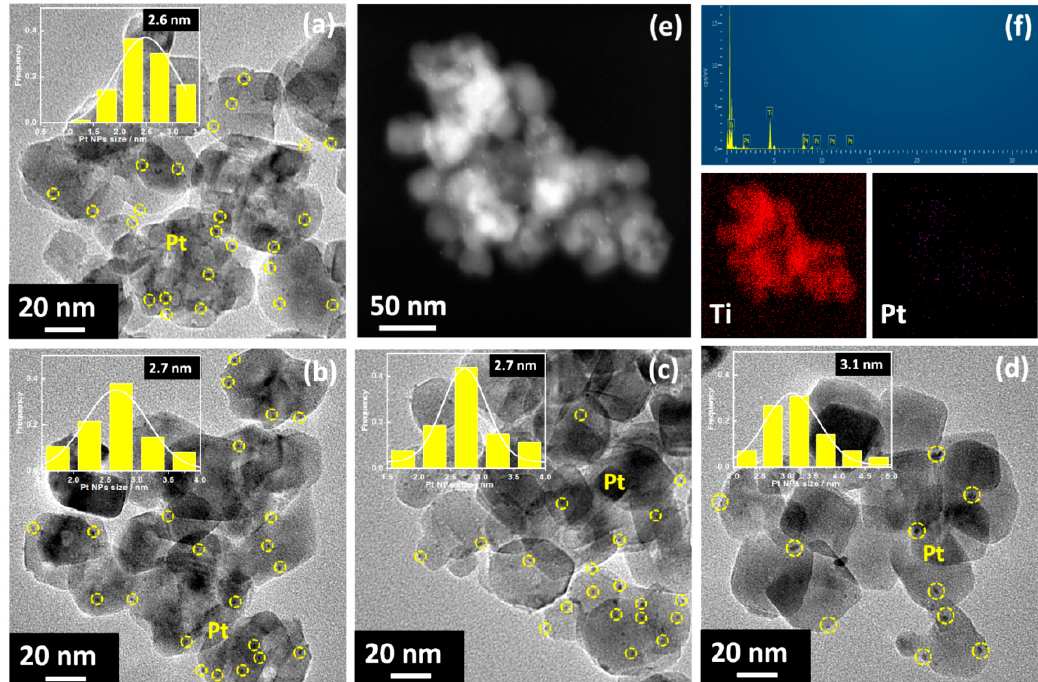
High-resolution transmission electron microscopy (HRTEM) images of ( a ) Pt / TiO 2 , ( b ) Pt / TiO 2 -O100, ( c ) Pt / TiO 2 -O200, ( d ) Pt / TiO 2 -O300, and a representative scanning transmission electron microscopy − high-angle annular dark-field (STEM − HAADF) image ( e ), scanning transmission electron microscopy − energy-dispersive X-ray spectroscopy STEM − EDX elemental mapping ( f ) of Pt / TiO 2 . Inset histograms are the Pt particle size distribution of di ff erent catalysts. Catalysts 2019 , 9 , x FOR PEER REVIEW